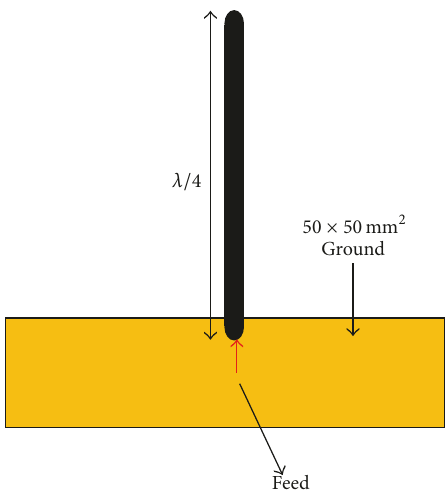
Figure 1: Geometry of the 𝜆/4 wire-monopole